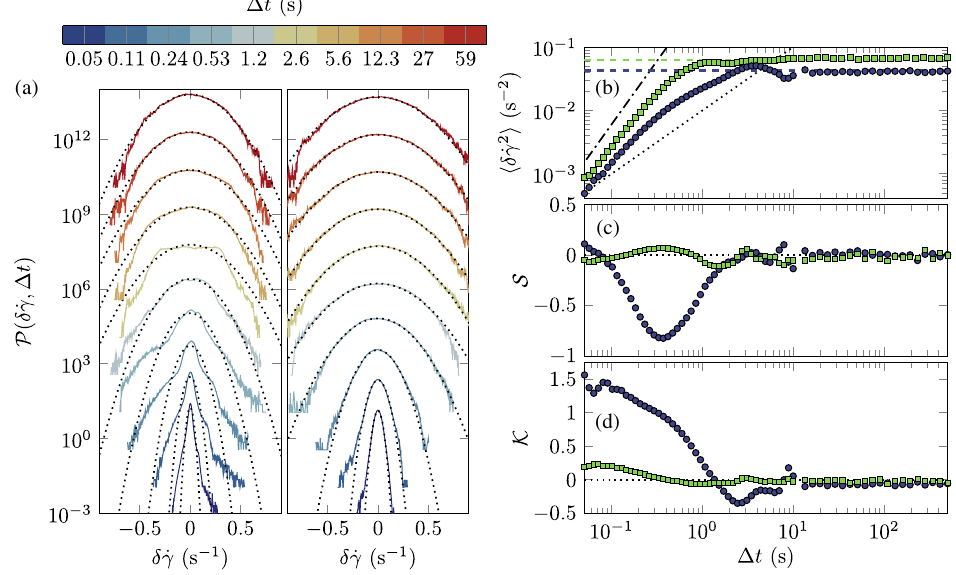
FIG. 3. Statistical properties of the shear rate increments δ _ γ ð t; Δ t Þ across the DST transition. (a) Probability density functions P ð δ _ γ ; Δ t Þ of the increments of _ γ ð t Þ in regime I (left, σ ¼ 16 Pa) and in regime II (right, σ ¼ 100 Pa) for several time lags Δ t (see color scale). Dotted lines show Gaussian distributions with the same variances as δ _ γ ð t; Δ t Þ . For clarity, successive PDFs were shifted vertically by 10 3 = 2 starting from Δ t ¼ 0 . 05 s. (b) Variance, (c) skewness, and (d) kurtosis of the shear rate increments for σ ¼ 16 Pa (blue circles) and 100 Pa (green squares). In (b) the thick dashed lines correspond to twice the variance of the shear rate, 2 ½h _ γ ð t Þ 2 i thin dotted and dash-dotted lines indicate h δ _ γ 2 i ∝ Δ t and Δ t 2 ,